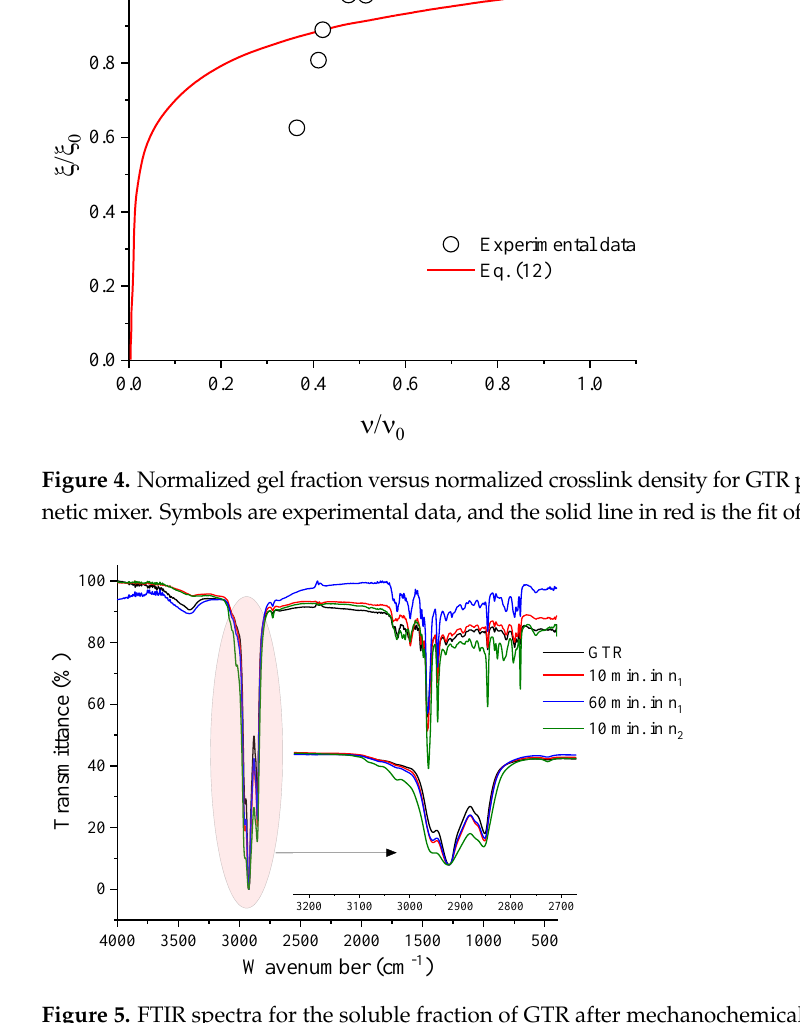
Figure 5. FTIR spectra for the soluble fraction of GTR after mechanochemical treatment.